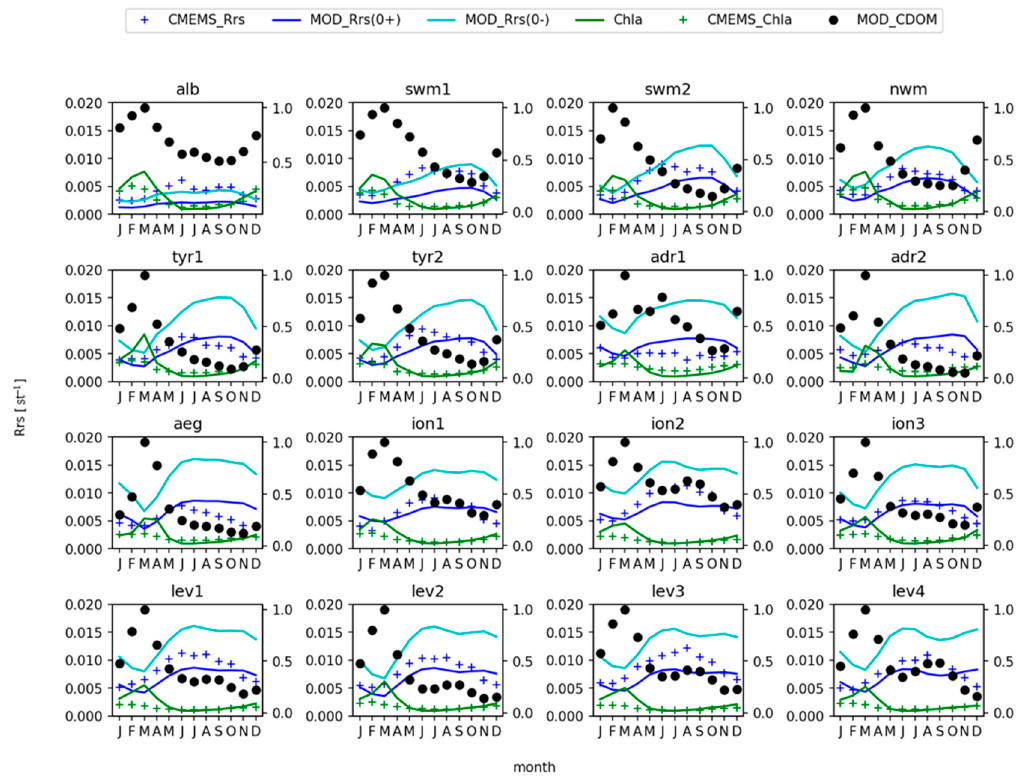
Figure 9. Same as Figure 7 but for EXP-3.